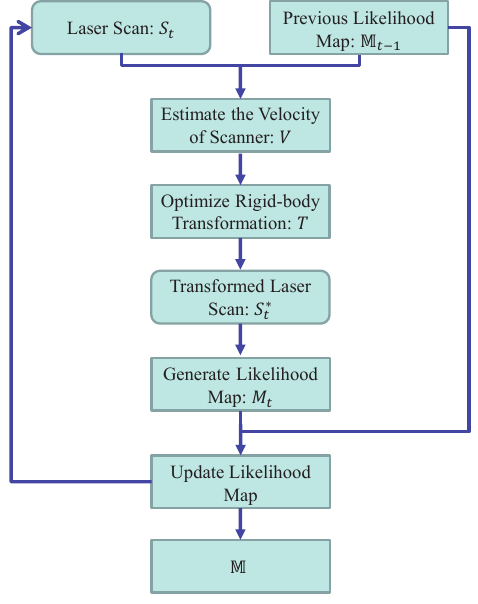
(cid:2424) Figure 2: The flowchart of our proposed SLAM